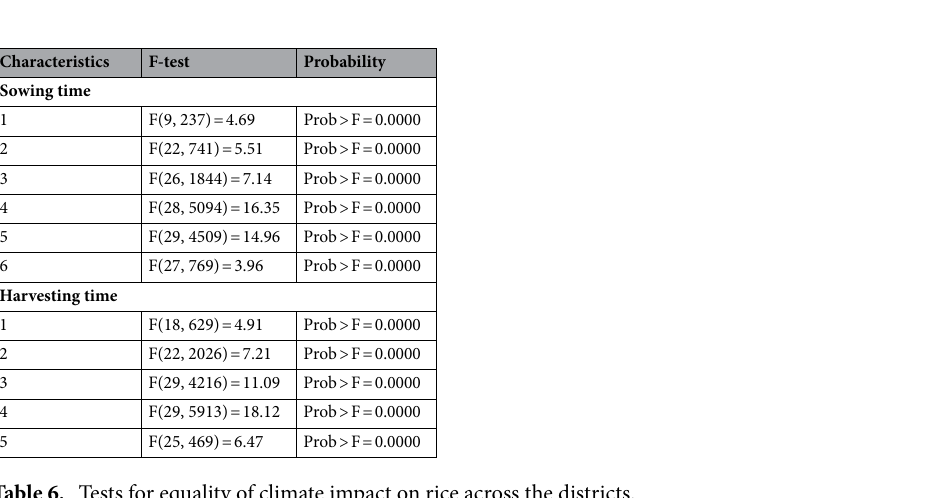
Table 6. Tests for equality of climate impact on rice across the